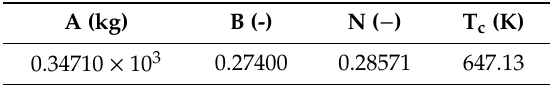
Table 3. Regression coe ffi cients for water density. Reproduced from [30], Elsevier and Gulf Professional Publishing: